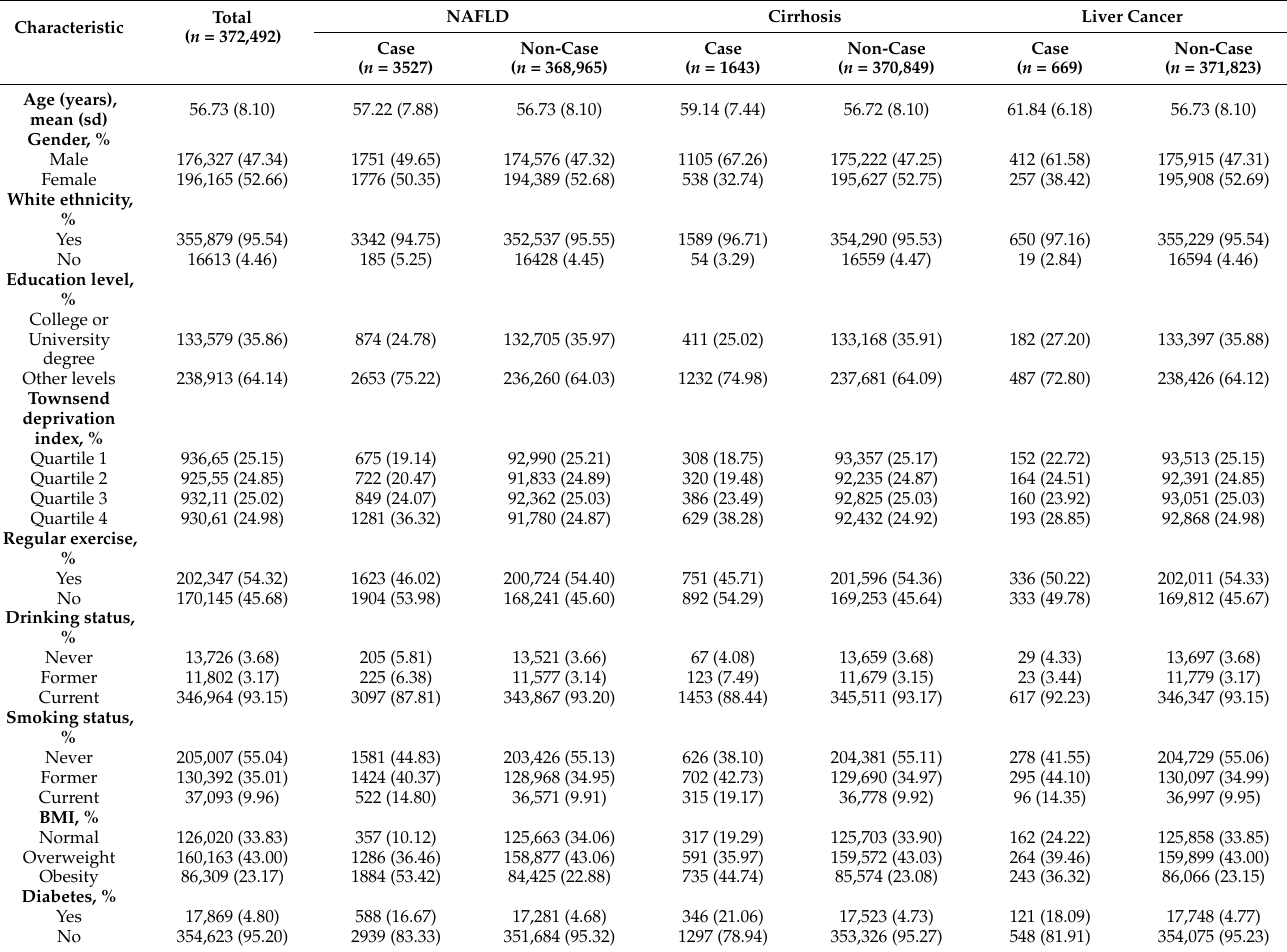
Table 1. Baseline characteristics of participants in UK